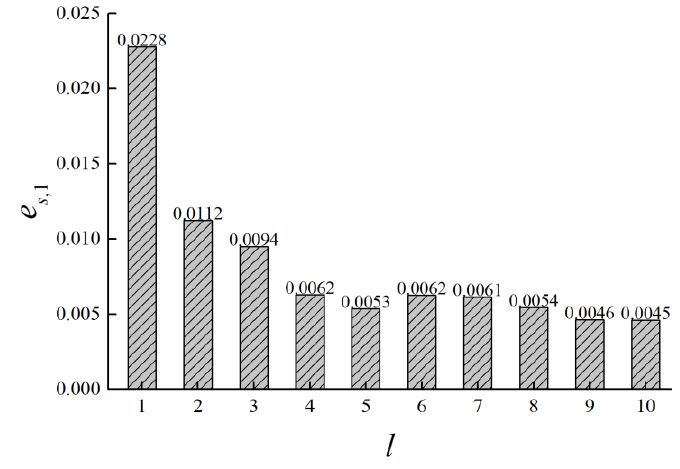
Figure 8. The relationship between the model prediction accuracy and the prediction lag degree. The precondition of Equation (26) is to use the model to predict the future H -step state. Therefore, it is necessary to consider the error accumulation of multi-step rolling prediction. Figure 9 shows the relationship between the model prediction accuracy e s ,1 and the prediction depth H . When the prediction depth H = 1, e s ,1 = 0.0006 is the lowest. With the increase in H , the prediction errors accumulated, but they all remained in the same order of magnitude, and all of them do not exceed 0.005. Therefore, the error accumulation of multi-step rolling prediction has negligible influence on the prediction accuracy.